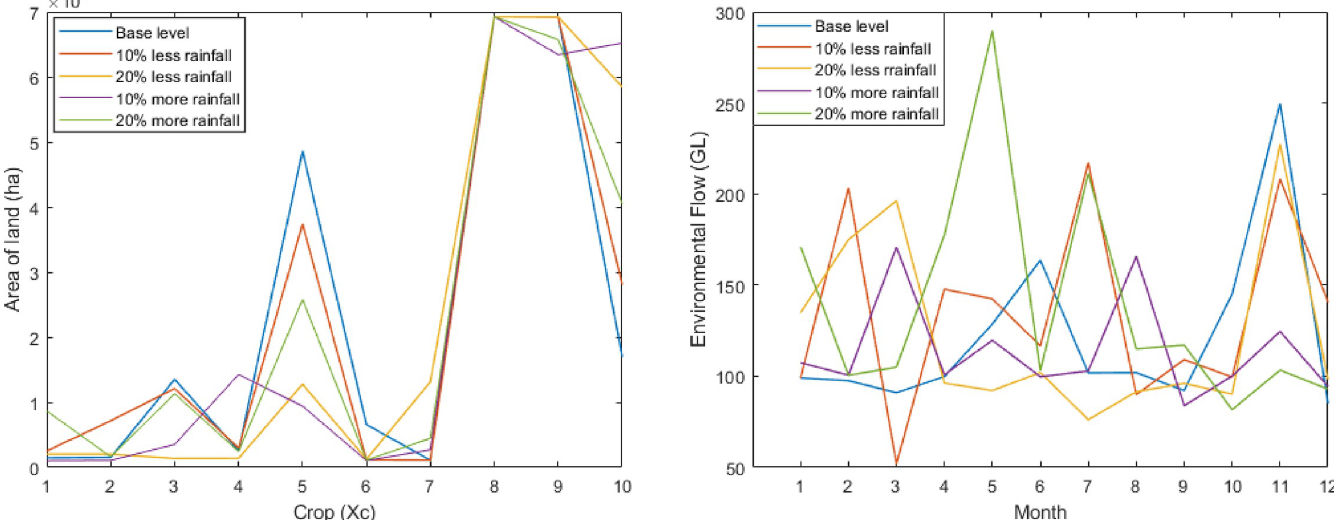
Fig 3. Effect of different rainfall on crops and environmental flow. (a) Crops pattern for different rainfall. (b) Environmental flow for different rainfall.